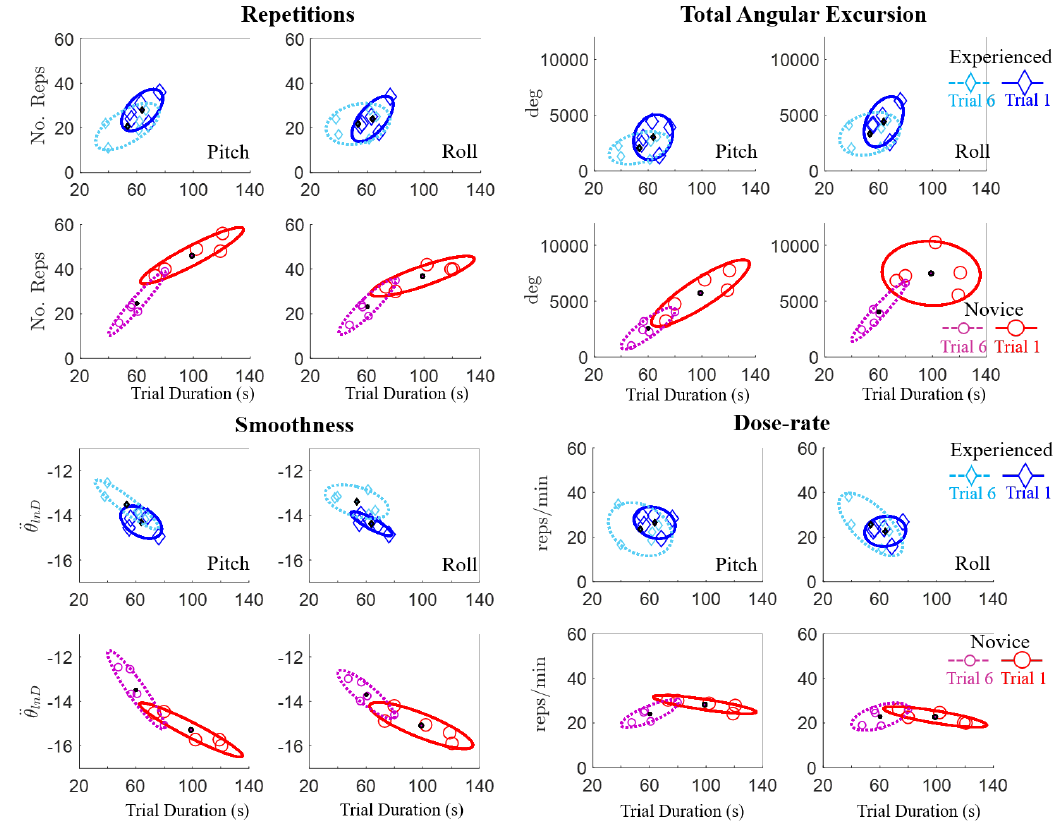
Figure 8. Motor learning differences of experienced and novice participant groups. Motor performance metrics including the number of repetitions (No. Reps), total angular excursion (Tot. Excursion: θ Tot ( ◦ )), smoothness (¨ θ lnD ), and dose-rate ( reps / min ) for pitch and roll motions are plotted versus trial duration (s) for the first (Trial 1) and last (Trial 6) trials. Individual participant performance (diamond and circle markers) and sample-distribution ellipses (75% confidence intervals) are also shown.